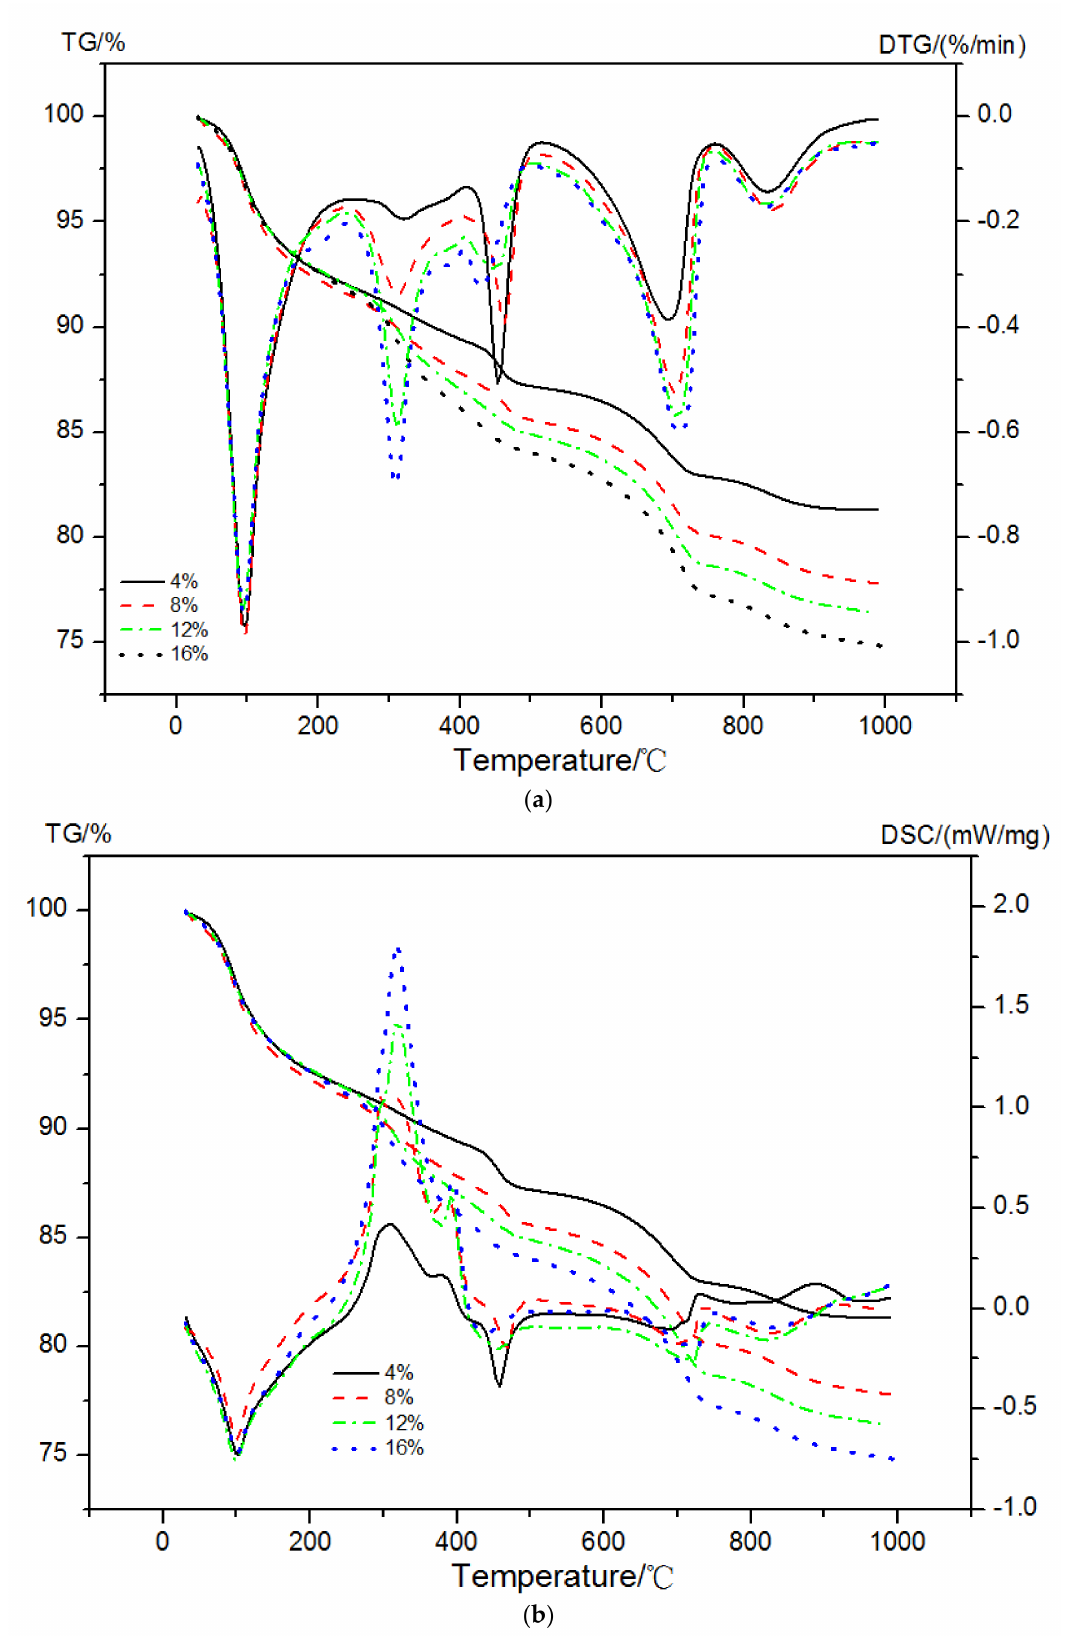
Figure 8. TG-DTG and TG-DSC curves of EVA-modified cement pastes. ( a ) TG-DTG, ( b )